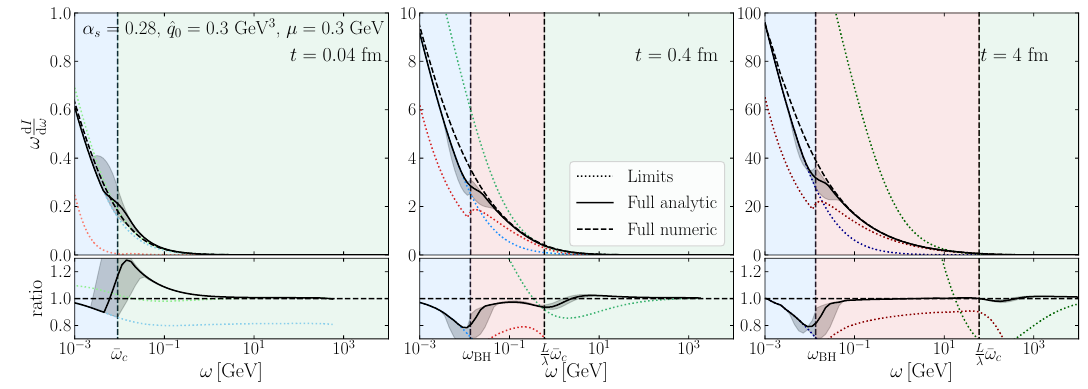
Figure 11 . Same as figure 7, on a semilog